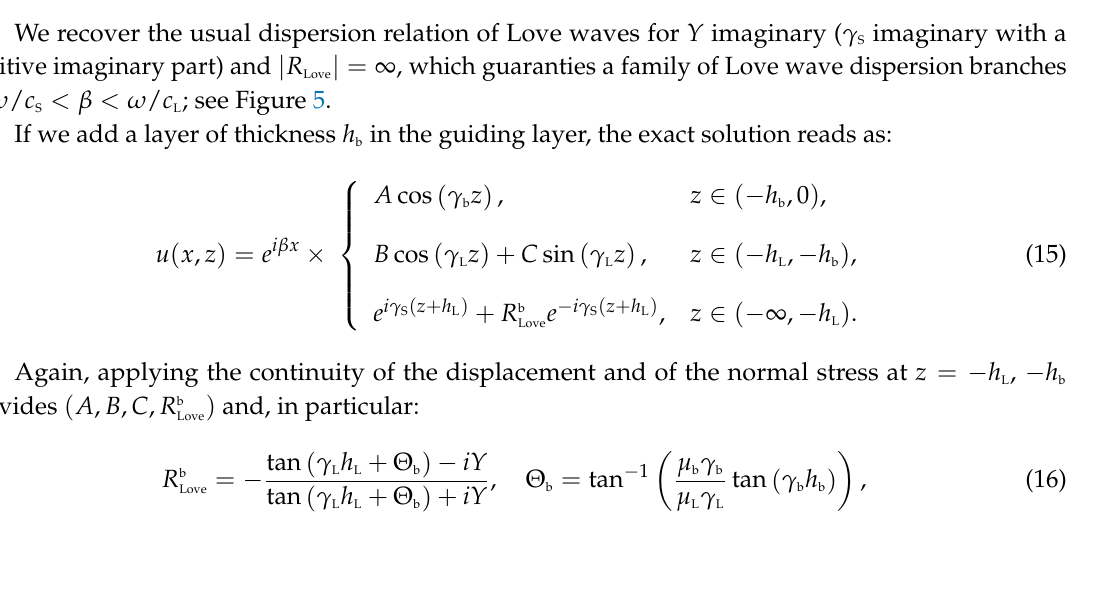
Figure 4. Configuration of the array. The total thickness H thickness H heterogeneities are considered, h